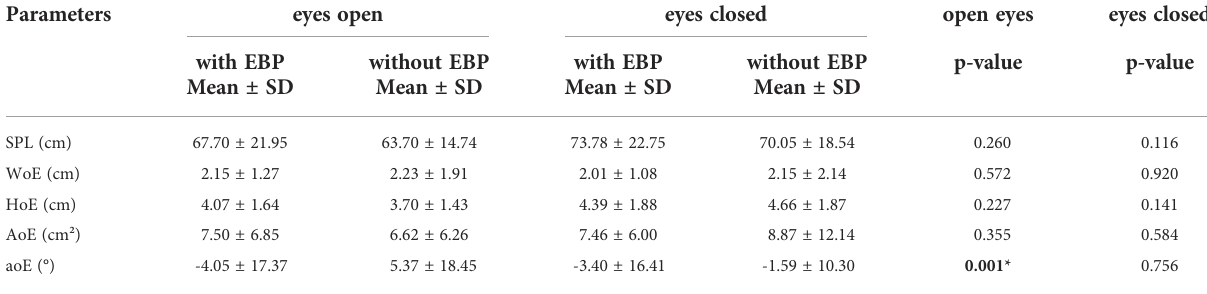
TABLE 6 Comparison of the results of posturographic tests conducted with and without EBP during independent standing in a free standing position with eyes open and closed (N = 52).